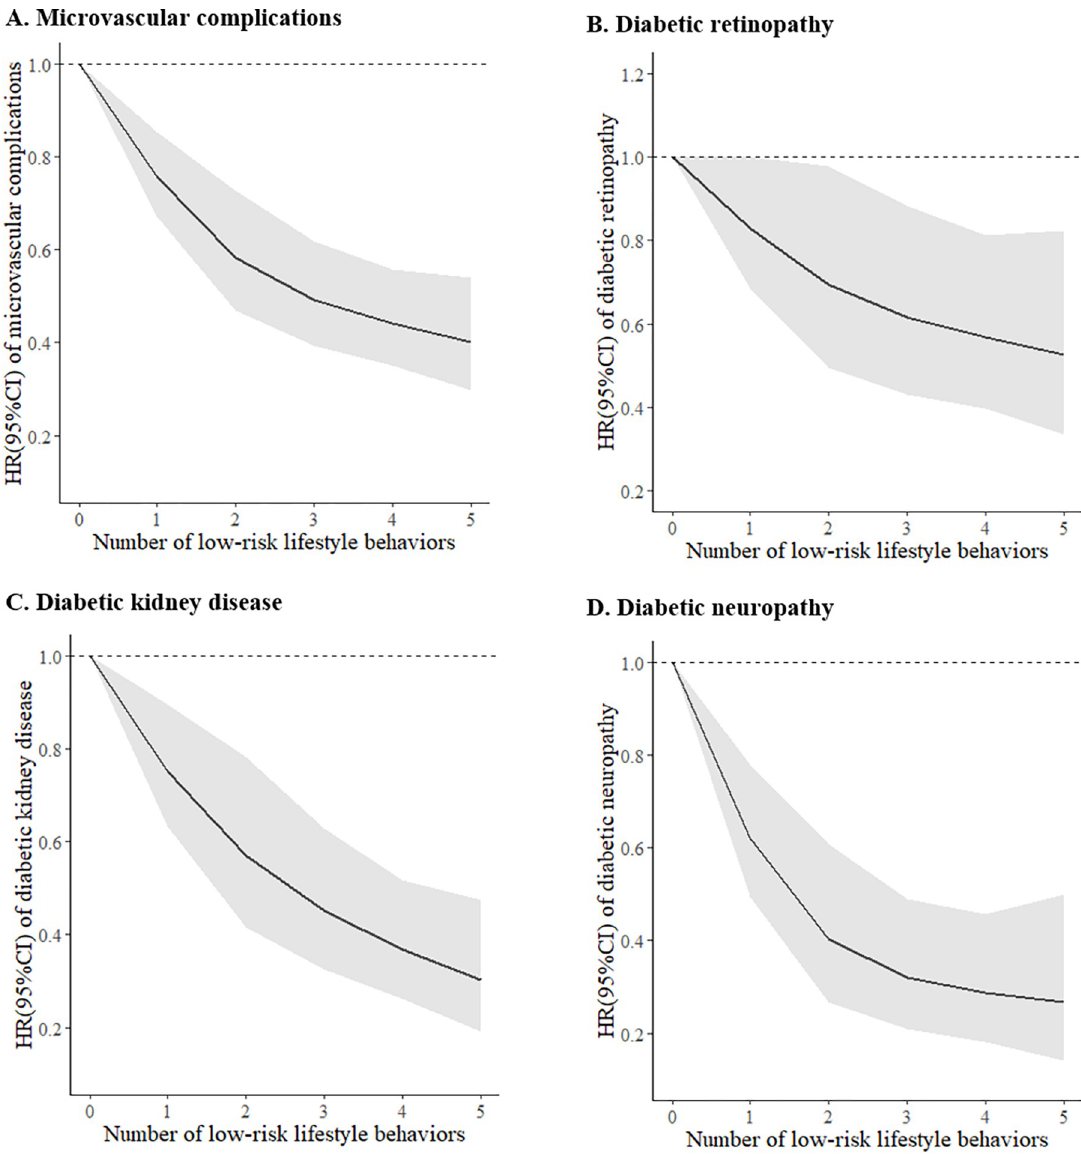
Fig 1. Dose–response relationship of the healthy lifestyle score with risk of microvascular complications among individuals with T2D. X-axis showed the numbers of low-risk lifestyle behaviors, and y-axis showed the HRs of the composite microvascular complications ( A ), diabetic retinopathy ( B ), diabetic kidney disease ( C ), and diabetic neuropathy ( D ). Black curves were HRs, and grey zones were 95% CIs. Multivariable-adjusted models were adjusted for age (continuous, years), sex (male, female), ethnicity (White, others), education attainment (college or university degree, A/AS levels or equivalent or O levels/GCSEs or equivalent or other professional qualifications, or none of the above), Townsend Deprivation Index (continuous), sleep duration ( < 6, 6–8, or � 9 hours/ day), family history of CVD (yes, no), family history of hypertension (yes, no), prevalence of hypertension (yes, no), diabetes duration (continuous, years), HbA 1c (continuous, mmol/mol), use of diabetes medication (none, only oral medication pills, or insulin or others), use of antihypertensive medication (yes, no), use of lipid-lowing medication (yes, no), and use of aspirin (yes, no). All P -nonlinearity were � 0.09 and all P for overall association were < 0.001 (except for diabetic retinopathy: P for overall association = 0.008). CI AU : AnabbreviationlisthasbeencompiledforthoseusedinFig 1 : Pleaseverifythatallentriesarecorrect : , confidence interval; CVD, cardiovascular disease; HR, hazard ratio; T2D, type 2